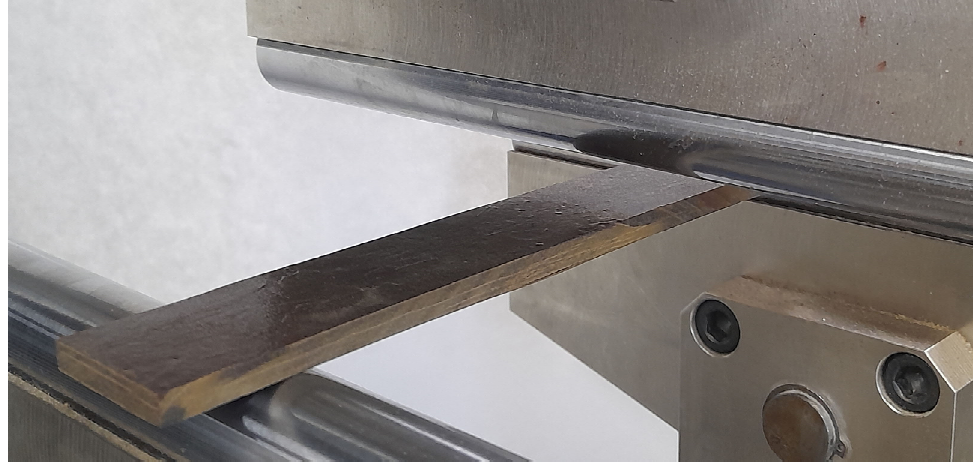
Figure 2. Manufactured sample during the bending test.